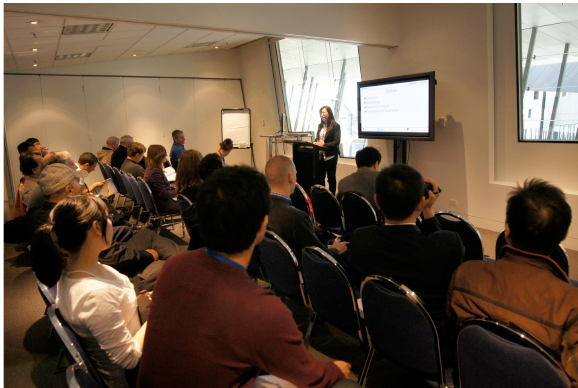
Figure 5. Youth forum presentations during the ISPRS congress in Melbourne in 2012.